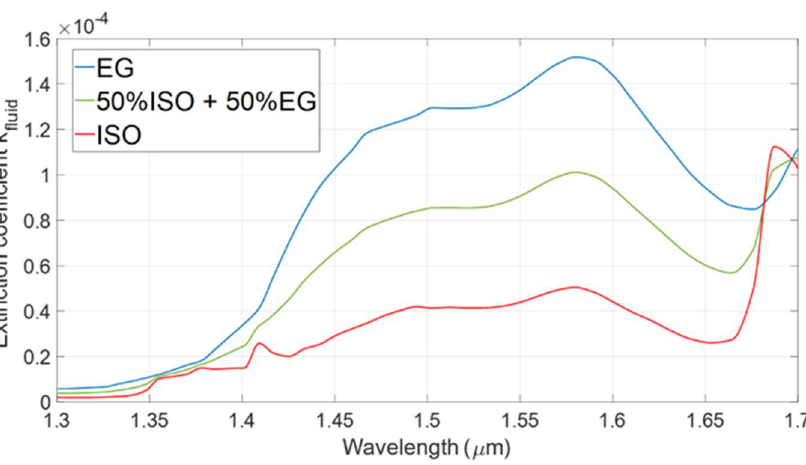
Figure 2. Extinction coefficient k fluid ( λ ) of isopropanol, ethylene glycol and solution of 50% of isopropanol (ISO) and 50% of ethylene glycol (EG) as functions of the wavelength. Data used to obtain this graph were found in [26,27] and they agreed with those reported in other sources [28–30].